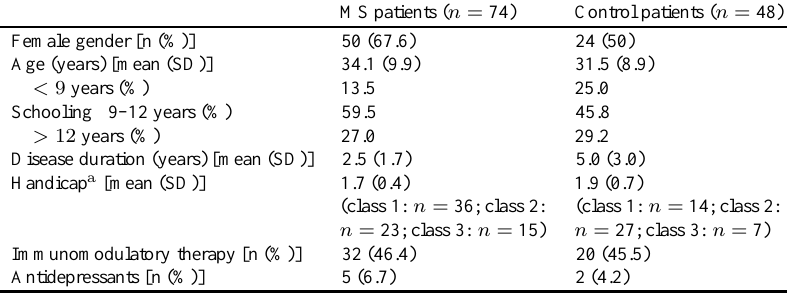
Table 1 Demographic data for the MS and control